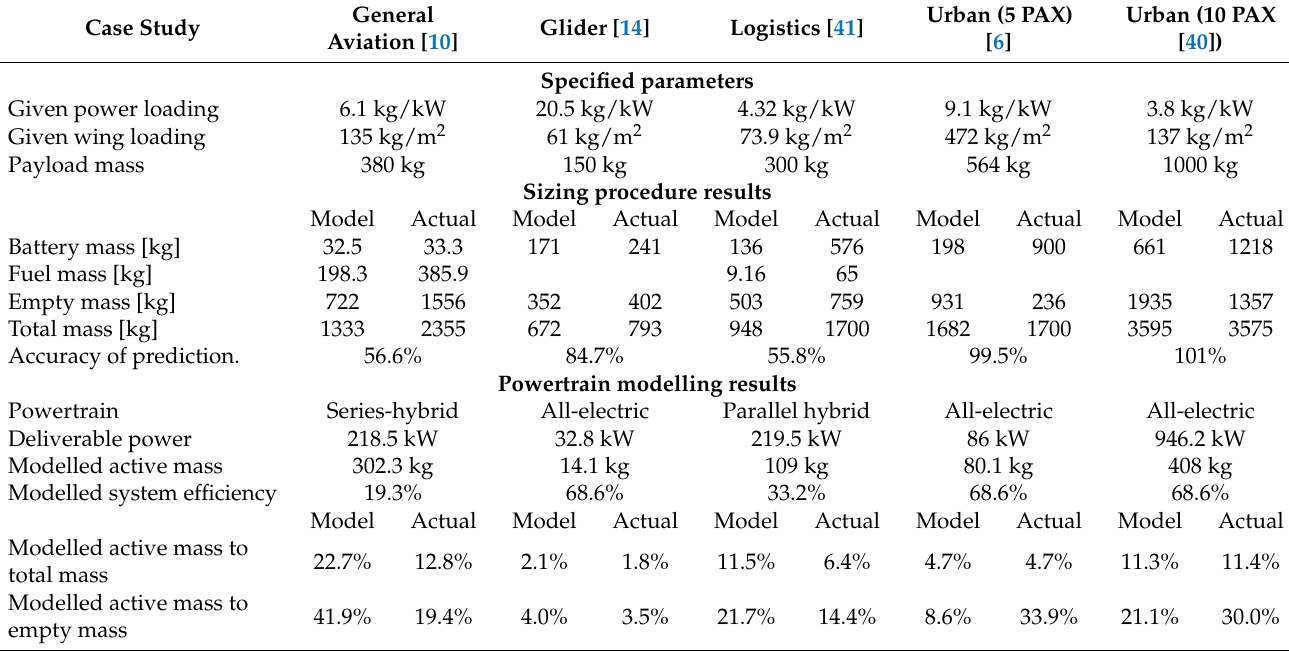
Table 7. Sizing and powertrain analysis